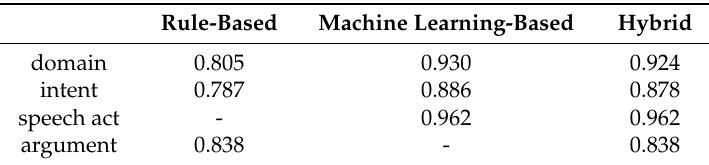
Table 2. Evaluation result of